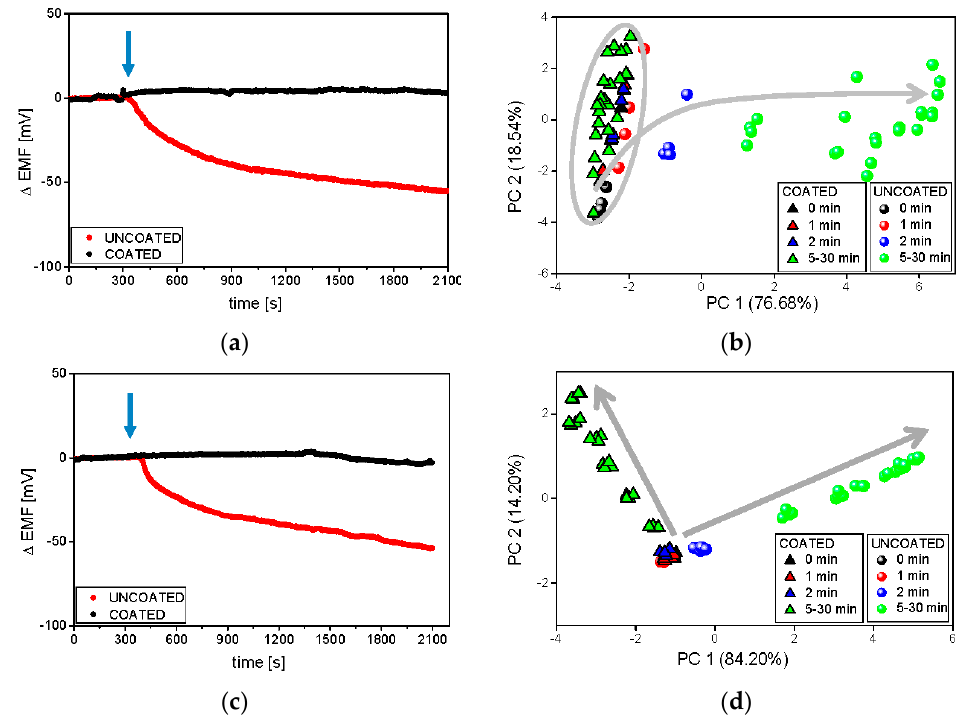
Figure 6. Raw signals of the PS-N electrode and respective PCA plots during the release process carried out at room temperature in phosphate buffer at pH 6.9, in various hydrodynamic conditions: batch ET ( a , b ), and flow-through ET ( c , d ). The blue arrows represent the moment of the introduction of minitablets into the dissolution medium. Grey arrows represent following time points.